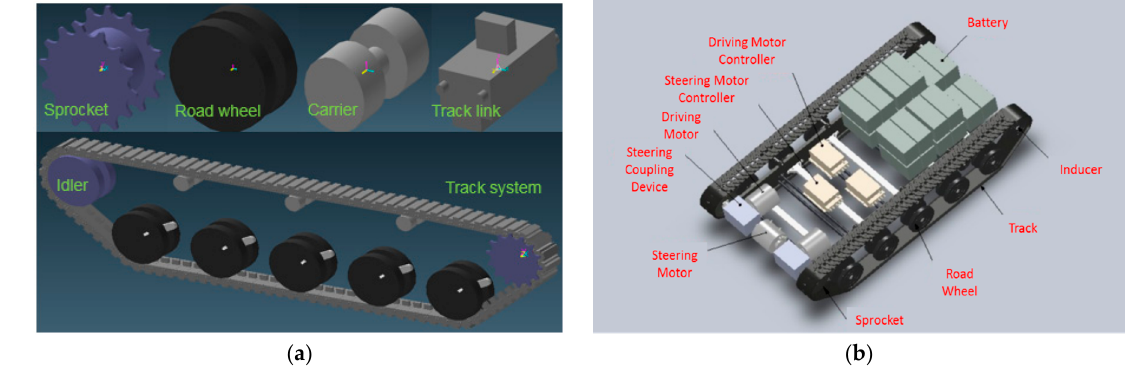
Figure 11. ( a ) Track modeling; ( b ) Vehicle modeling.